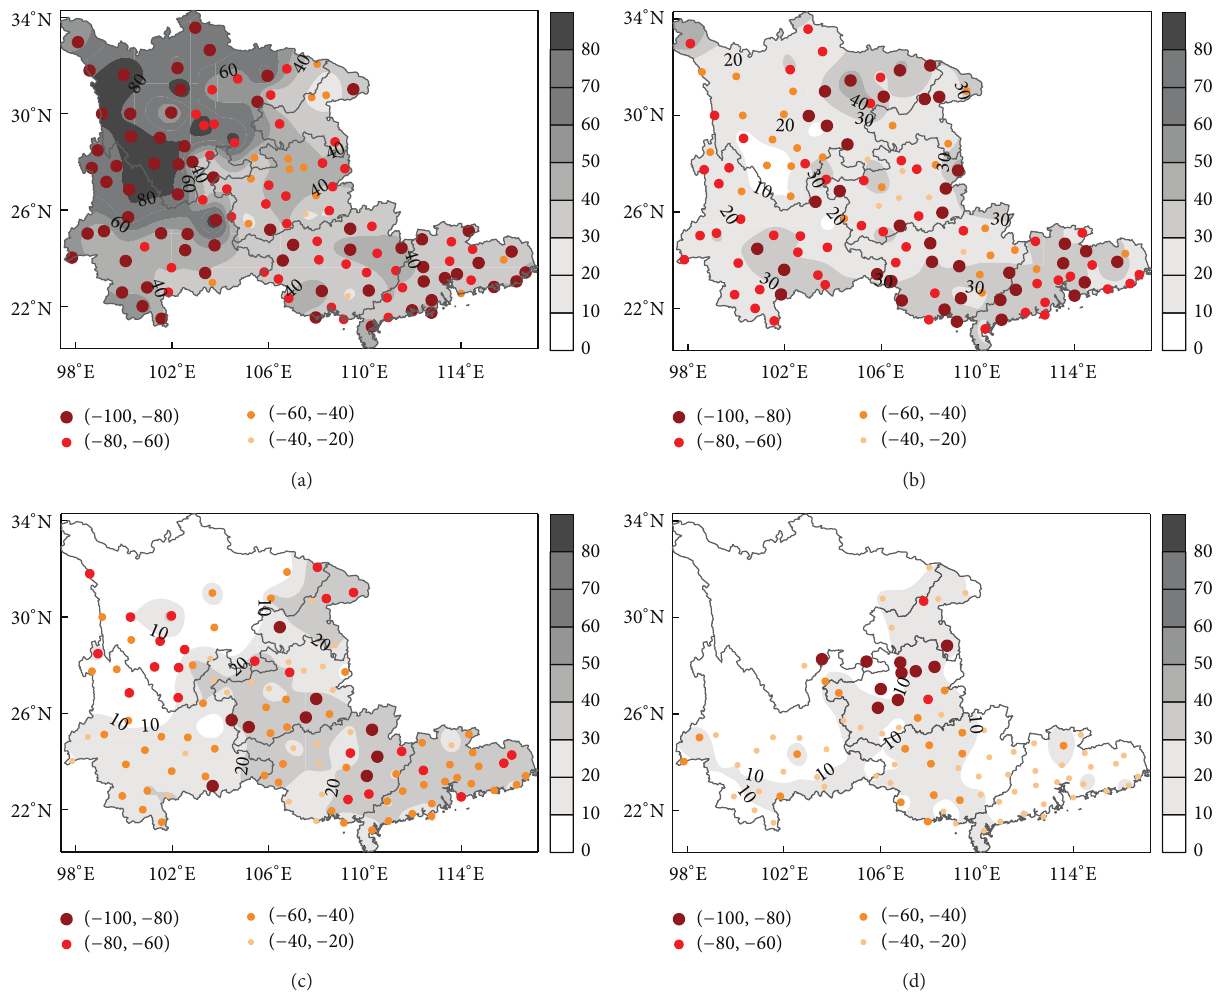
Figure 7: The first 4 precipitation deficits (colored dot, unit: %: (a) the first; (b) the second; (c) the third; (d) the fourth) under one-month timescale and the proportion of droughts (blank map, unit: %) due to varying degrees of